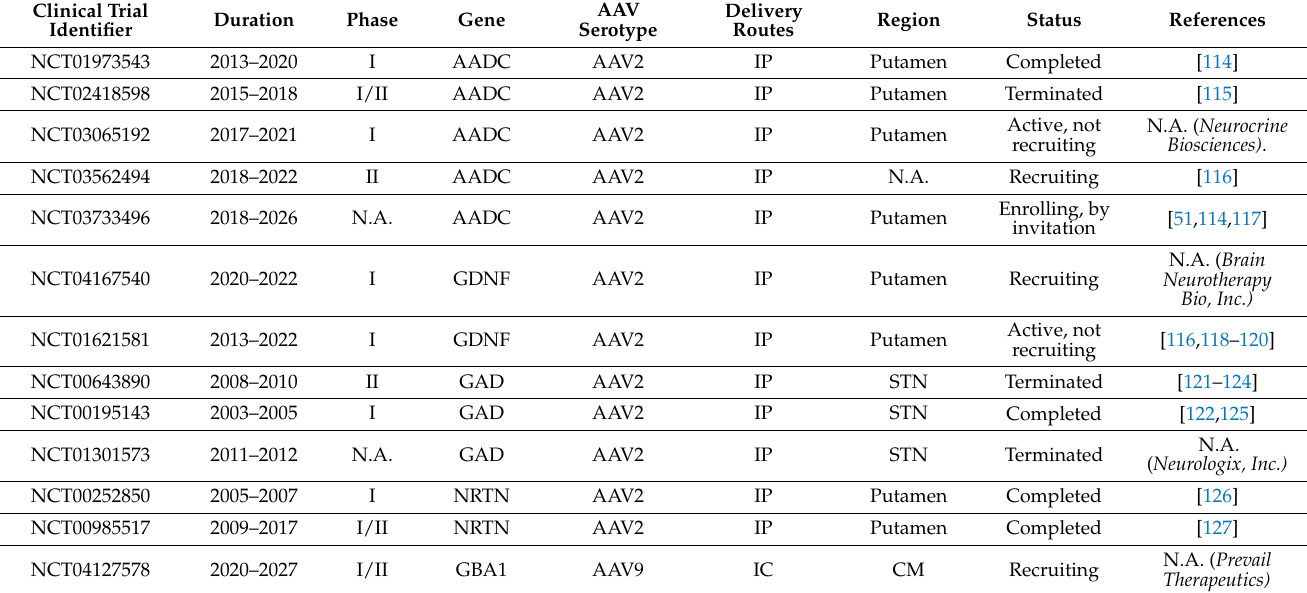
Table 2. Clinical trials for PD (http://www.genetherapynet.com/clinical-trials.html, last access 14/06/2021). AADC: human aromatic L-amino acid decarboxylase; NRTN: Neurturin; STN: Subtalamic Nucleus; IP: Intraparenchymal; IC: Intracisternal; CM: Cisterna Magna. Clinical Trial